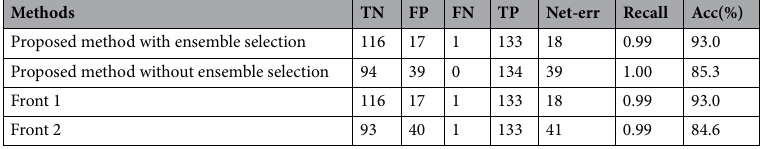
Table 3. Comparison of the proposed ensemble method with and without using classifier selection strategy.